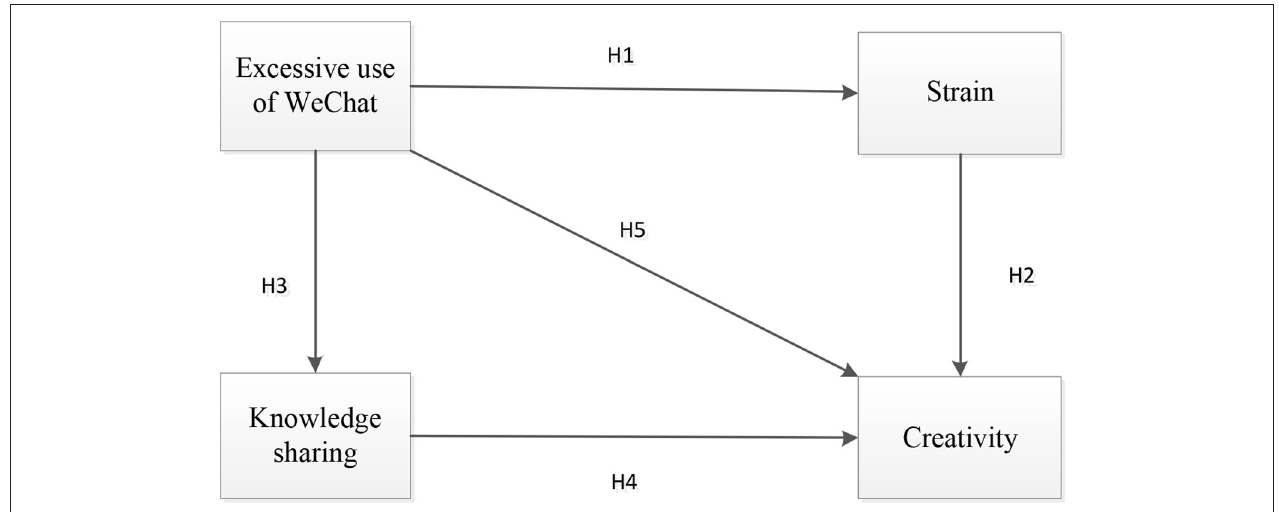
FIGURE 1 | Research